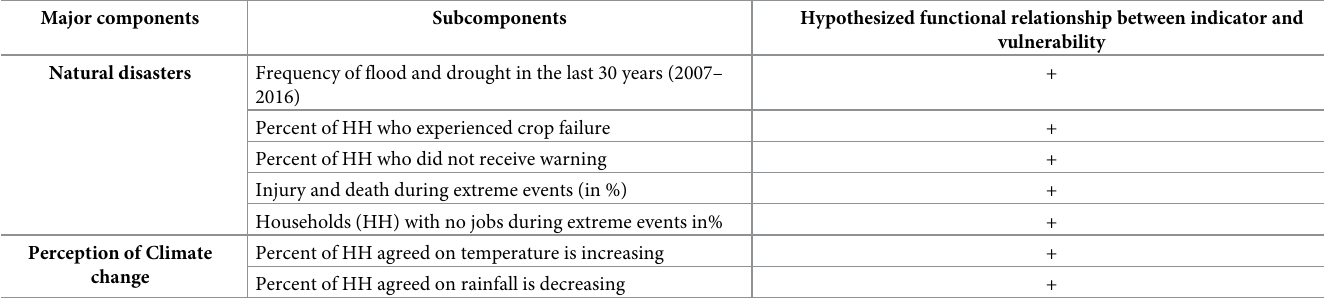
Table 2. Exposure major components, sub-components and their hypothesized effect with